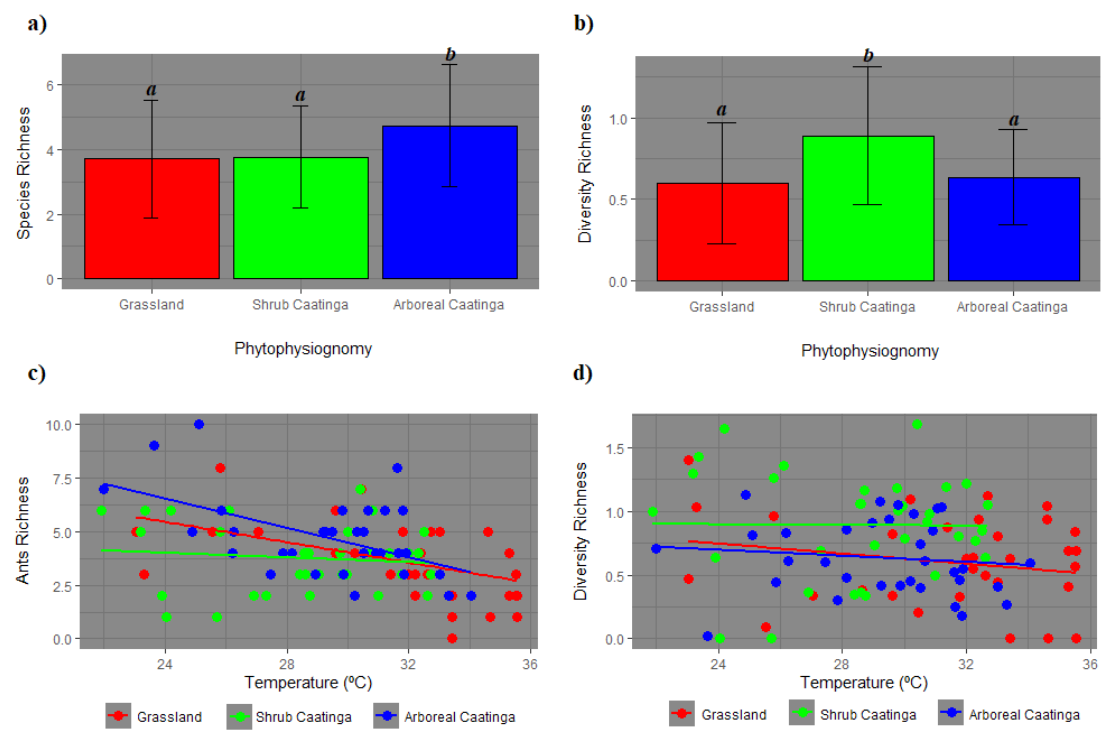
Fig 3. Average richeness ( a ) and average diversity ( b ) species of ants foraging throughout the day (7 am to 6 pm) among different phytophysiognomies of Caatinga biome, Bahia State, Brazil. Different letters indicate significant difference between the phytophysiognomies (p≤0.05). Influence of temperature in average richness ( c ) and average diversity ( d ) foraging throughout the day (7 am to 6